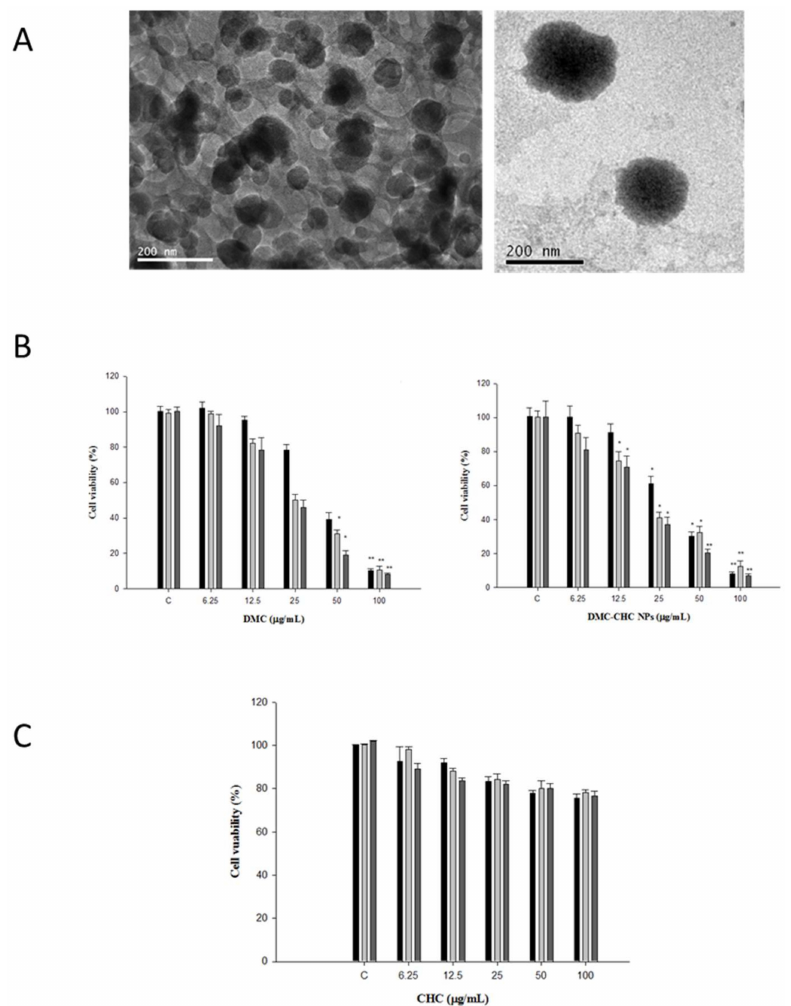
Figure 1. Characteristics of CHC and DMC-CHC NPs. ( A ) TEM morphology of CHC and DMC-CHC NPs (scale bar: 200 nm). Left one is unloaded CHC, and right one is DMC-CHC nanoparticles. ( B ) Left panel: effect of DMC on the viability of A549 cells. Right panel: effect of free DMC-CHC NPs on the viability of A549 cells. ( C ) CHC nanomatrix (6.25, 12.5, 25, 50, and 100 µ g/mL) were incubated with A549 for 24 h, 48 h, and 72 h. The results showed that the CHC nanomatrixes demonstrated no cytotoxicity on A549. Each data point is represented as the mean ± SD ( n = 3). Error bars represent standard deviation. * Indicates the values significantly different from the control time points, 24 h, 48 h, and 72 h., respectively. (* p < 0.05; ** p <